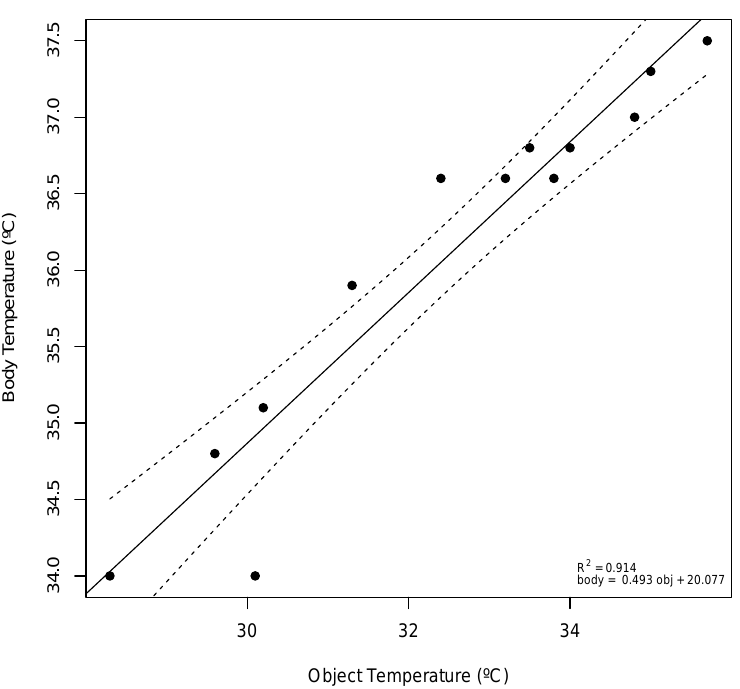
Figure 6. Object and body temperatures measured with a F102 IR thermometer. A linear regression was computed to obtain the linear transformation performed between both